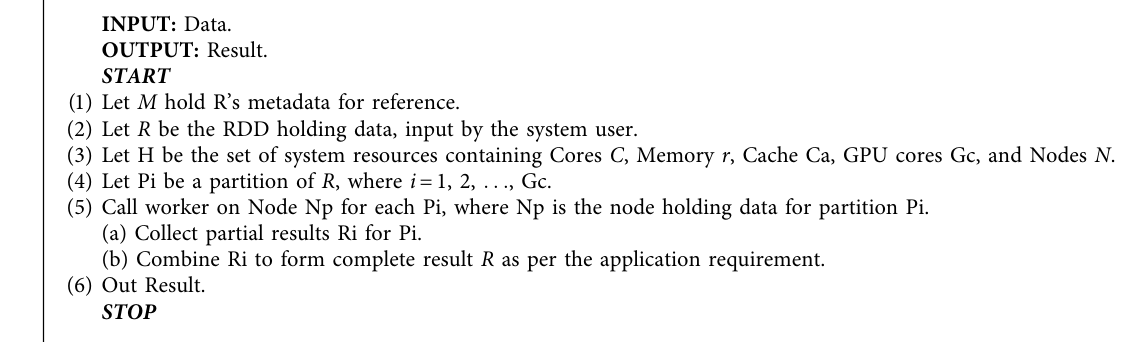
Algorithm 2, and the data structure example of the virtual topology is shown in Figure